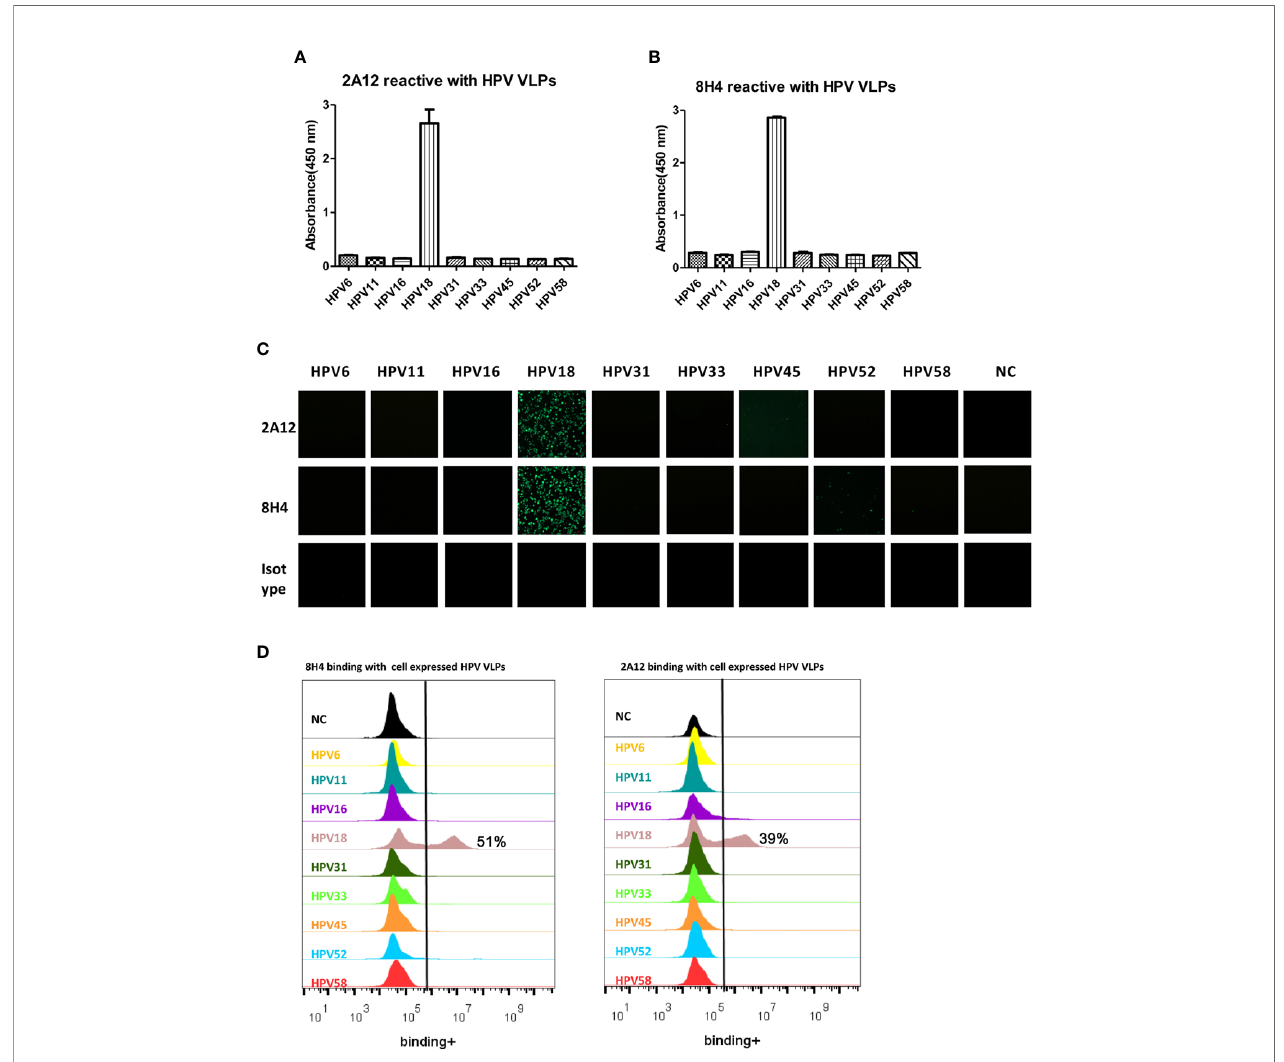
FIGURE 3 | Characterization of binding speci fi city of 2A12 and 8H4. Analysis of 2A12 (A) and 8H4 (B) binding with VLPs derived from various subtypes of HPV by ELISA. Data represent mean ± SEM. (C) 2A12 and 8H4 binding with various subtypes of HPV VLPs detected by immuno fl uorescence assay. Isotype control antibody (Isotype) was taken as a negative control. (D) 2A12 and 8H4 binding with various subtypes HPV VLPs detected by FACS. All experiments were repeated